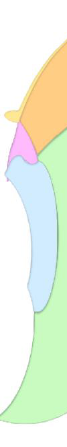
Figure 7. 3D view of the 3 potential therapeutic targets for drugs. Targets are represented as surfaces, they are shown on one monomer of HA. Polypeptide HA1 of HA is in orange and polypeptide HA2 is in green. Target residues described in Figures 3 and 4 are in blue. Target 1 (Pocket #9) is located at the globular head of HA, its residues are mainly located on HA1. This target has residues of target D described in Figures 3 and 4. Target 2 (Pocket #67) is located at the bottom of the HA stem in HA2 and has residues of target A described in Figures 3 and 4. Target 3 (Pocket #83) is located in the fusion domain, in contact with the HA2 B-loop that plays an essential role in membrane fusion. This target has residues of target F described in Figures 3 and 4.